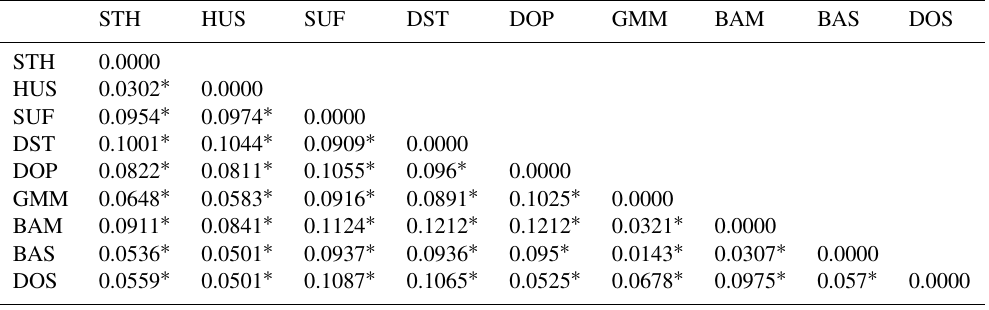
Table 4. Pairwise differences between population ( F ST ) using microsatellite markers. STH